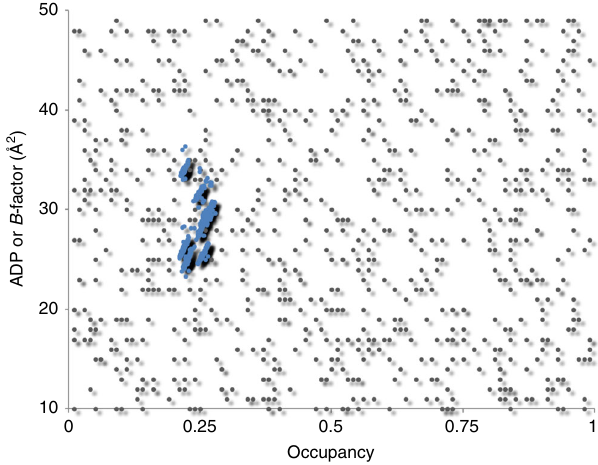
Fig. 3 Results of occupancy re fi nement with differing starting points. One hundred starting models with initial occupancies and ADP values for K + ions randomly drawn from [0 – 1] to [10 – 50] ranges for each of eight K + ions per structure (gray dots). The re fi ned K + occupancy values for each K + ion (blue dots) cluster around 0.25